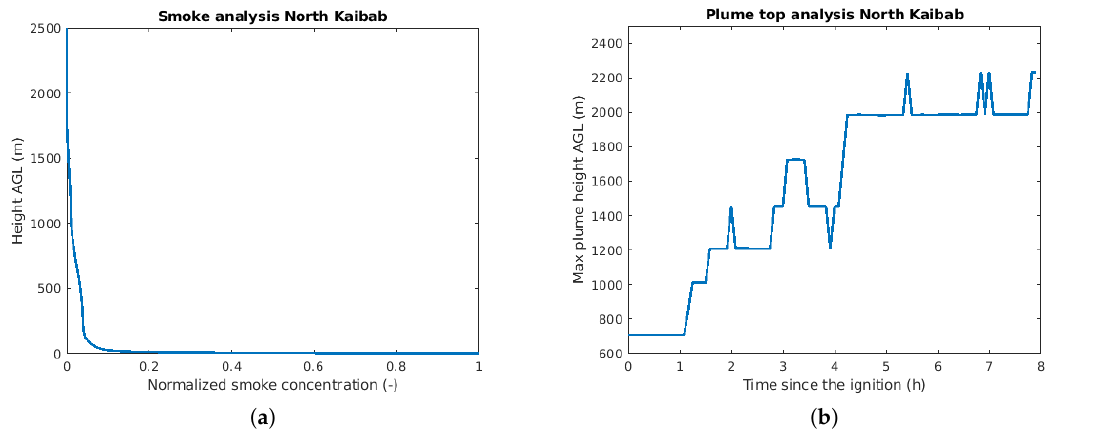
Figure 9. Smoke analysis for the North Kaibab burn simulation executed for 09/05/2008. ( a ) Vertical profile of normalized smoke concentrations; ( b ) Time series of the simulated plume top height.